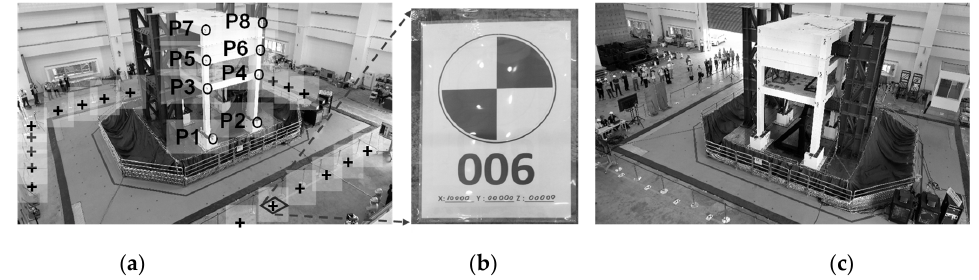
Figure 11. The 3-story RC building specimen and known calibration points marked. Points data in these photos are used for the second stage of the two-stage calibration approach. ( a ) Left camera view. ( b ) Physically deployed marker. ( c ) Right camera view.